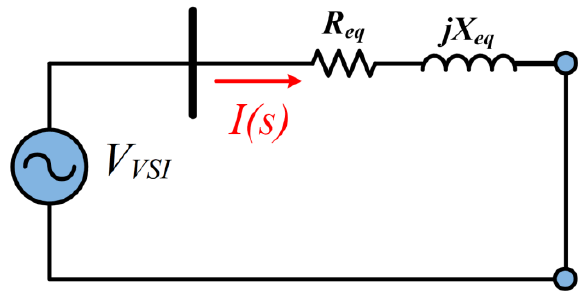
Figure 7. Equivalent circuit used for the transformer.